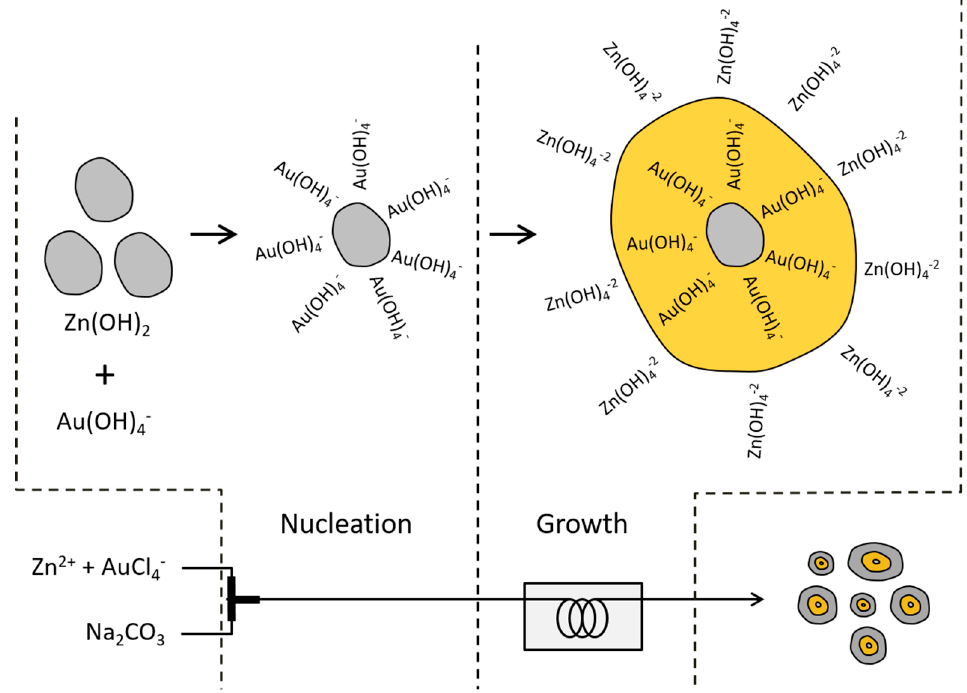
Figure 7. Schematic growth diagram of the core-shell Au/ZnO structure synthesized in a micro-reactor in this study.